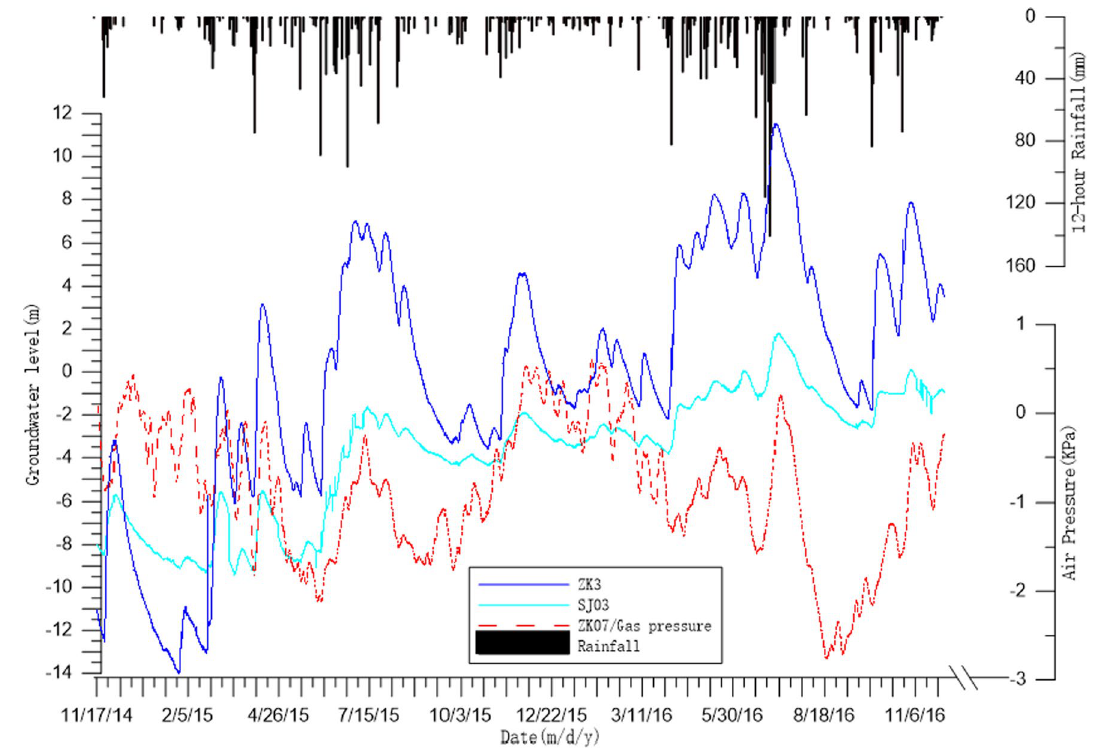
Fig. 6 Groundwater-gas pressure variations in monitoring wells ZK07, SJ03 and